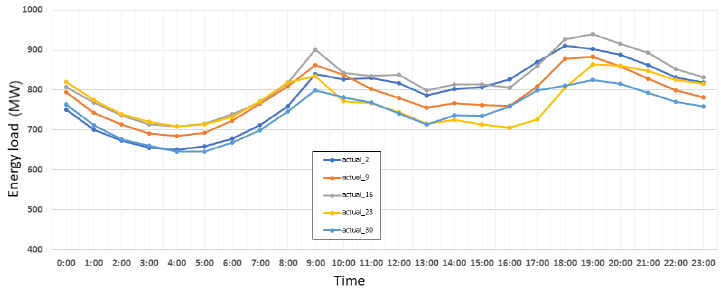
Figure 12. Energy consumption on Wednesdays in January 2019.